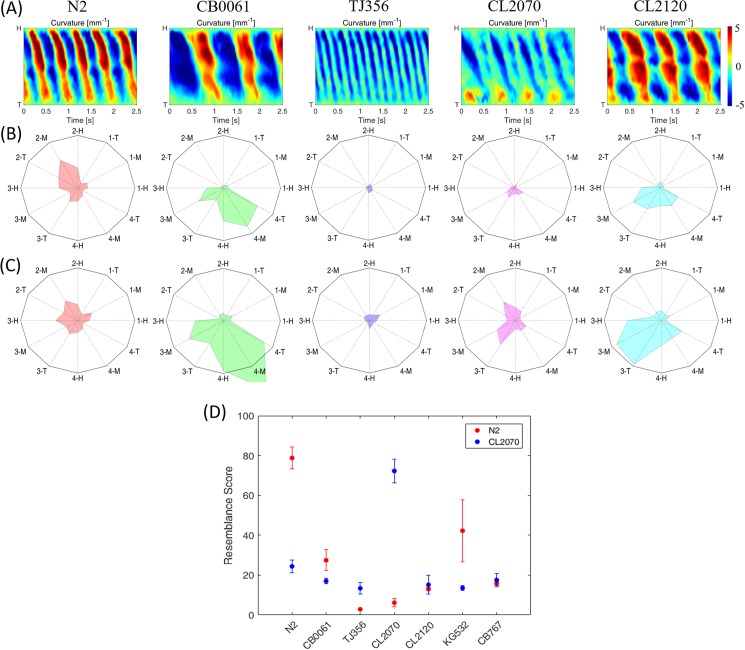
Strain recognition tests for actual worms.(A) Kymograms of the five strains, including N2, CB0061, TJ356, CL2070, and CL2120, used in the study. (B) Gaitprints of the worms against the database N2. (C) Gaitprints of the worms against the CL2070 database. (D) Resemblance scores of all the worms compared with the N2 and CL2070 databases. Red and blue circles denote comparisons achieved against the N2 and CL2070 databases, respectively.